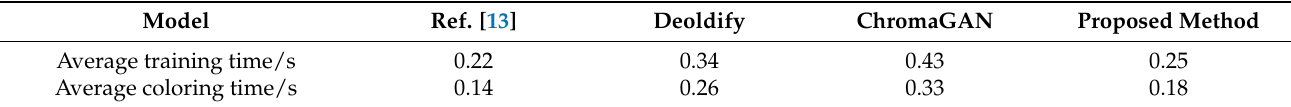
Table 4. Time complexity test.